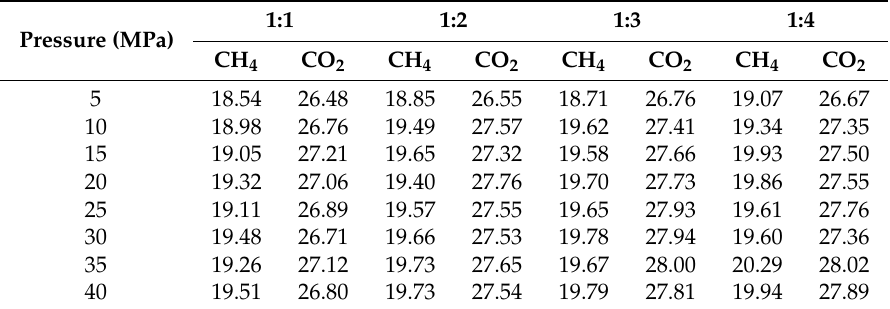
Table 1. The isosteric heat of adsorption of mixture in different proportions (Unit: KJ/mol).